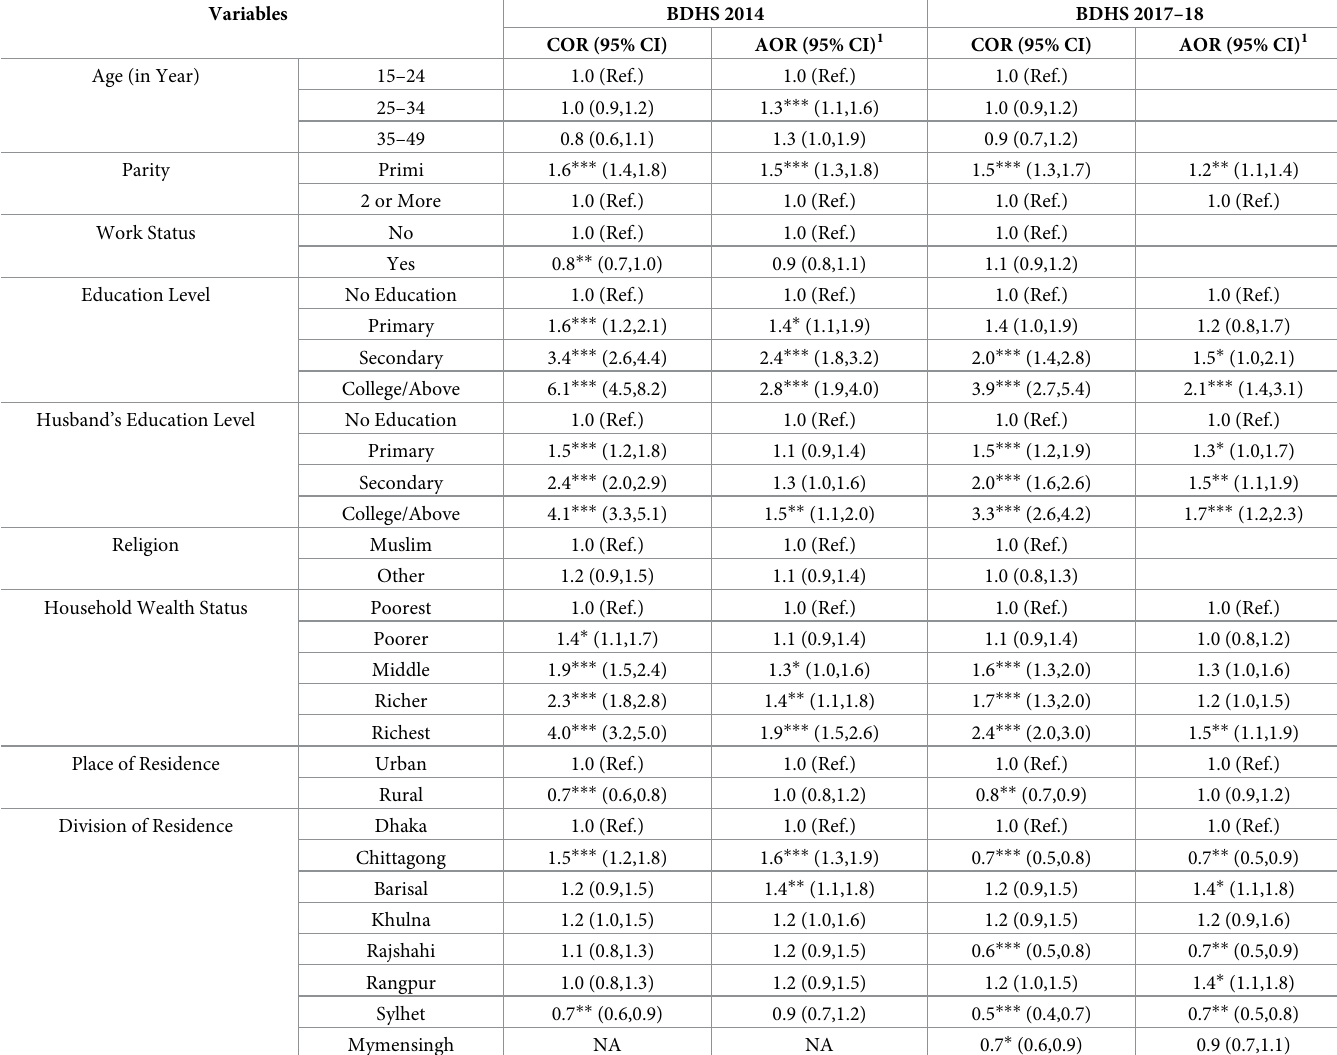
Table 3. Factors associated with mobile phone use for pregnancy-related causes by survey period, BDHS 2014 and BDHS 2017–18.